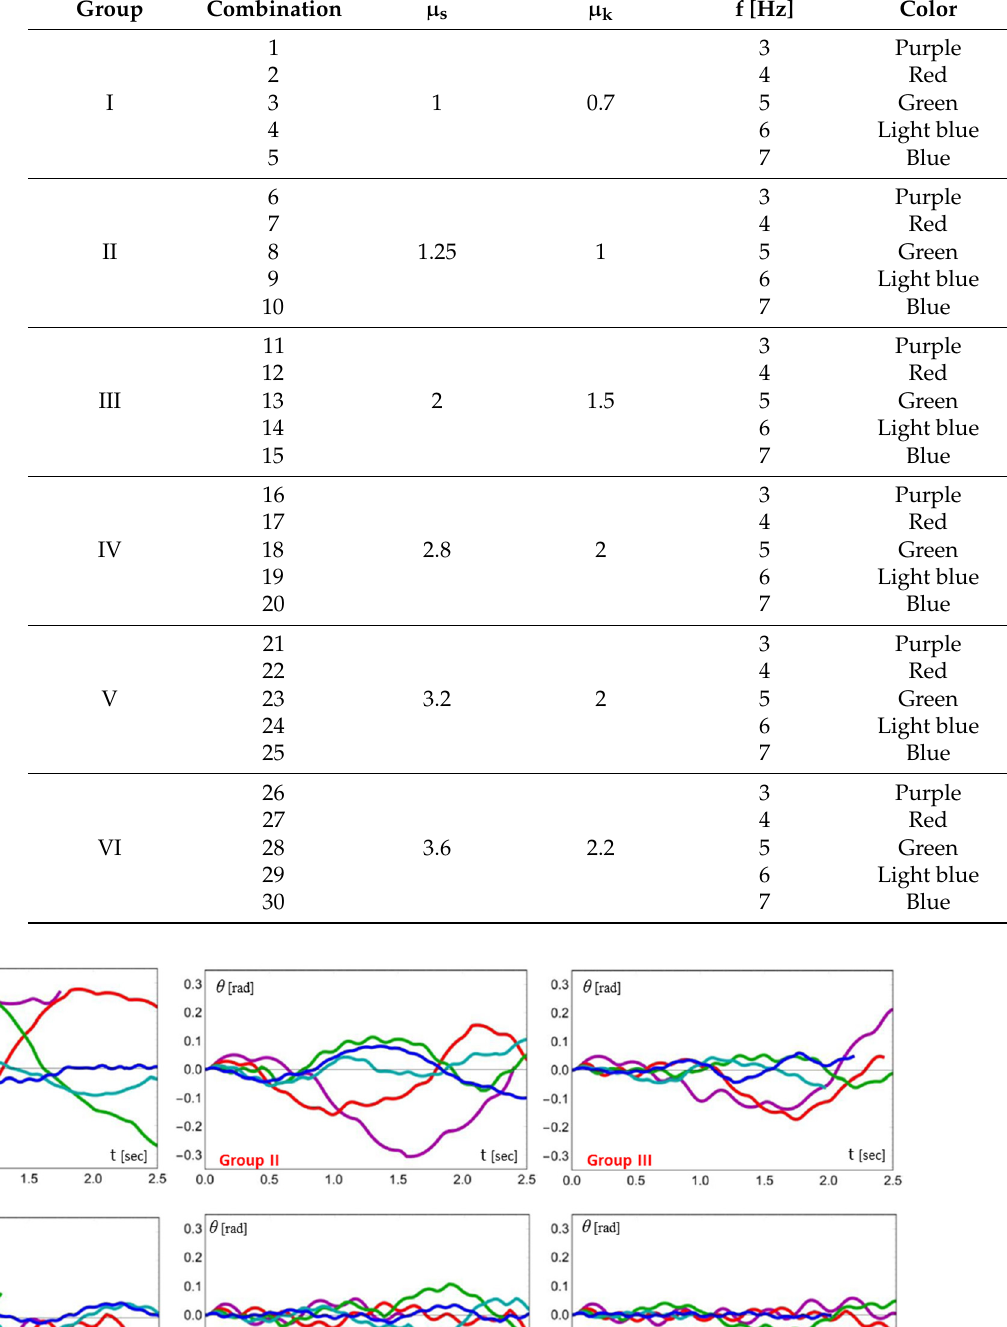
Table 2. Groups of combinations for a=0.4 g